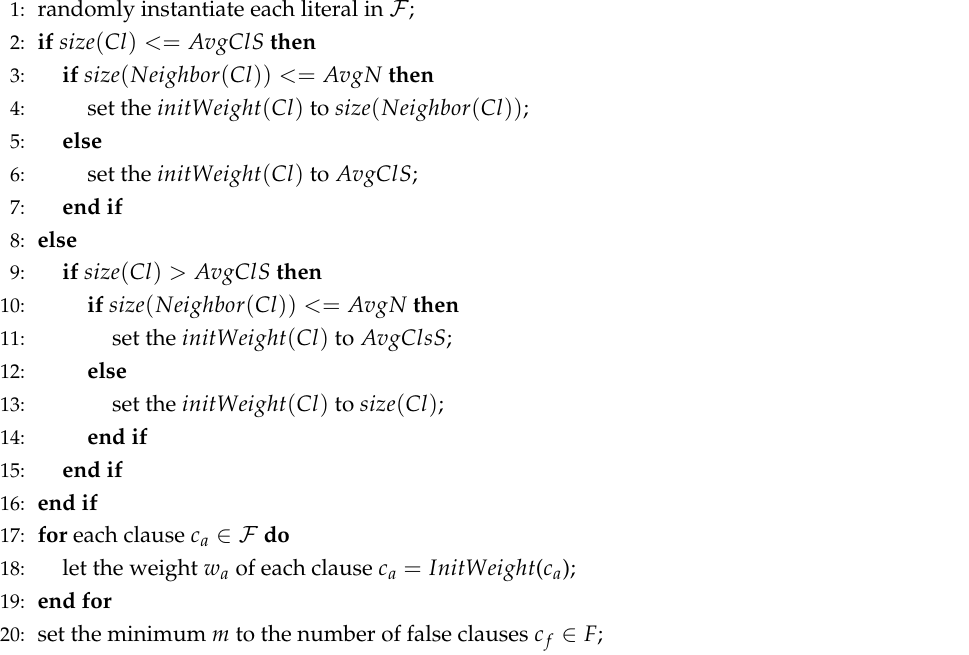
Algorithm 1 DDFW( F ) +